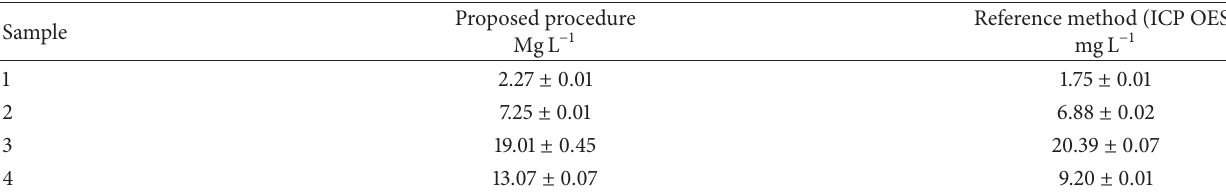
Table 3: Results comparison.